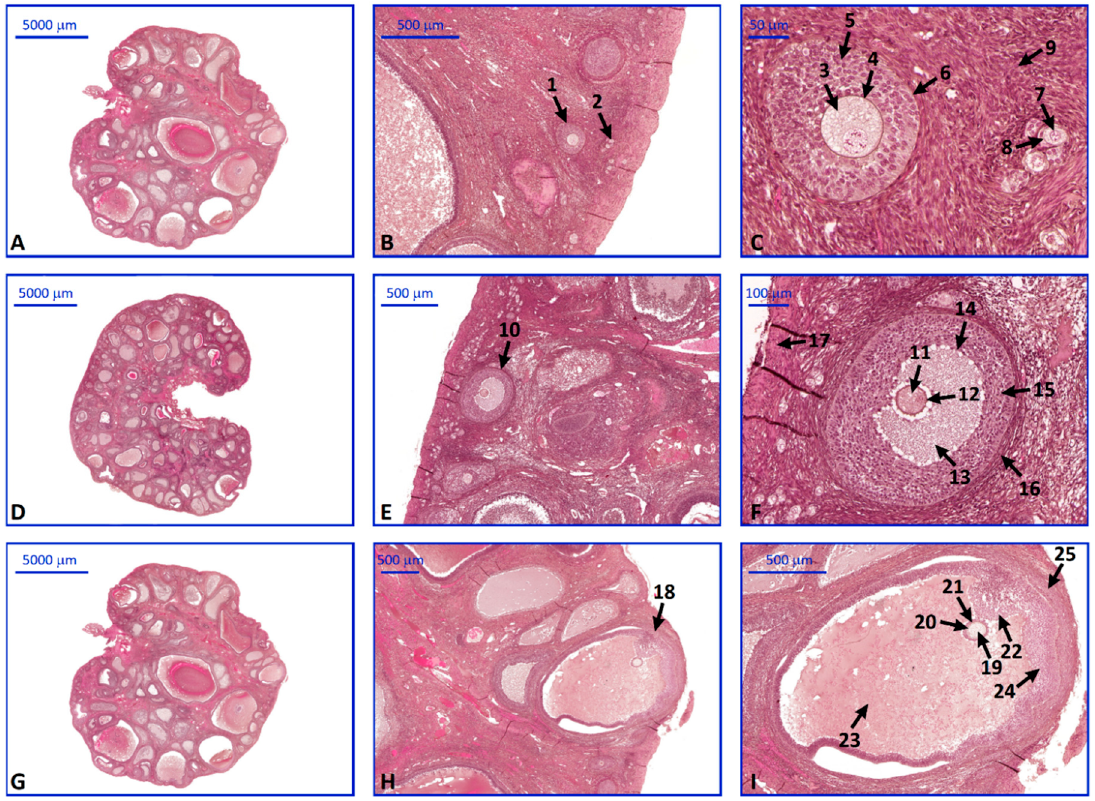
Figure 7. Representative sections of pubertal crossbred Landrace gilt ovaries stained with ( H ) and ( E ). ( A – C ). primordial and primary follicles, ( D – F ). secondary follicle, ( G – I ). Graafian follicle. Arrows: